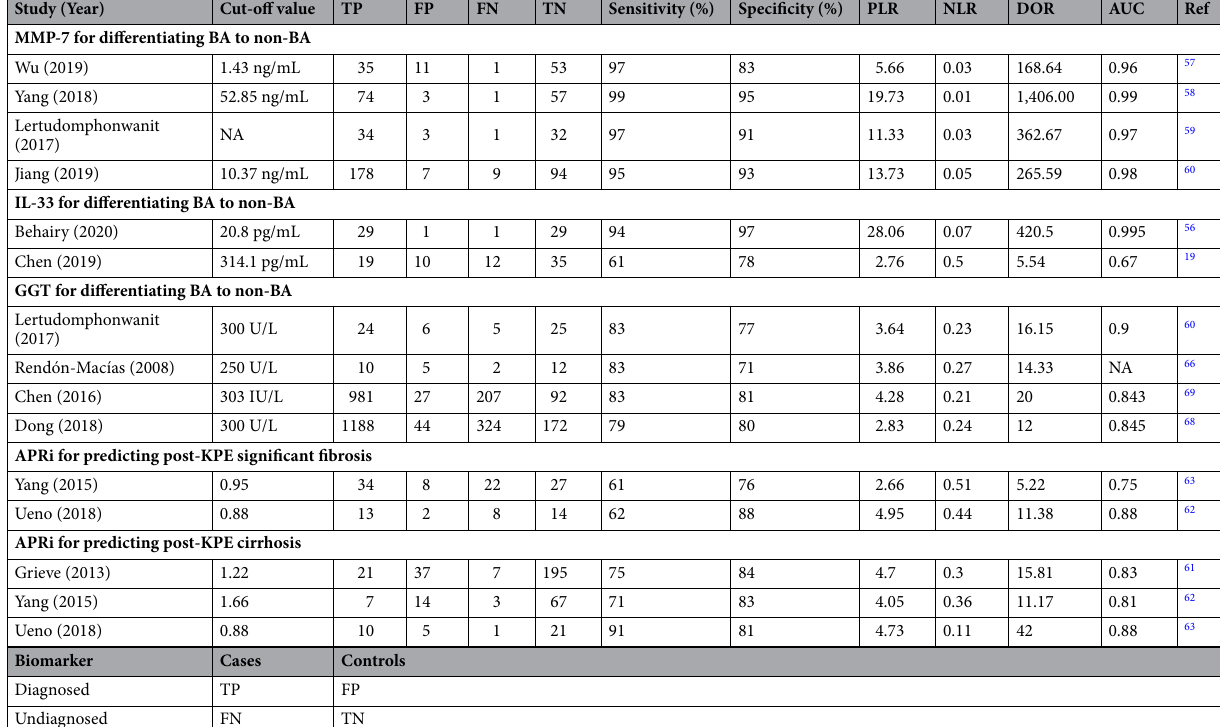
Table 3. Summary of diagnostic test accuracy data in individual studies. Abbreviations: BA, biliary atresia; MMP-7, matrix metallopeptidase-7; IL-33, interleukin 33; APRi, aspartate aminotransferase to platelet ratio index; post-KPE, after Kasai portoenterostomy; TP, true positives; FP, false positives; FN, false negatives; TN, true negatives; PLR, positive likelihood ratio; NLR, negative likelihood ratio; DOR, diagnostic odds ratio; AUC, area under the curve. Sensitivity = TP/Cases; Specificity = TN/Controls; PLR = Sensitivity/(1-Specificity); NLR = (1-Sensitivity)/Specificity; DOR =